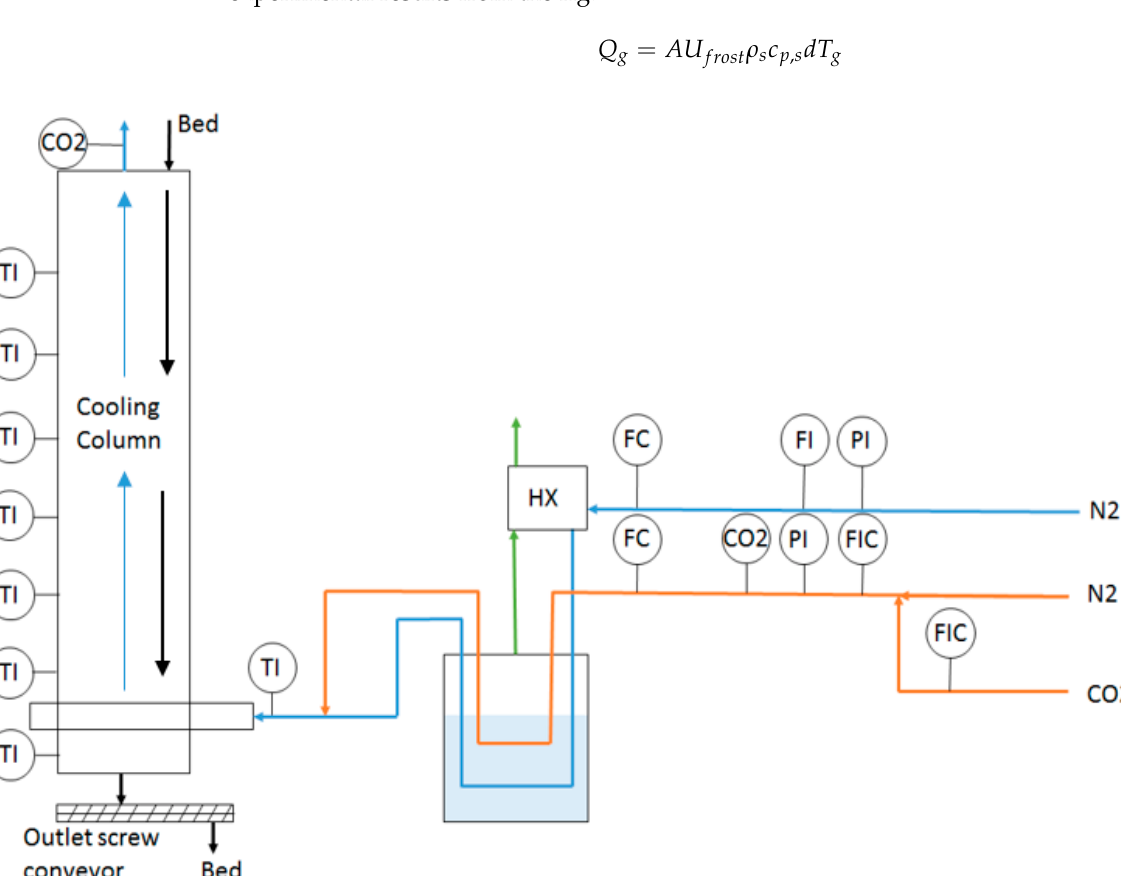
Table 1. Inlet flue gas flow rate conditions for cryogenic rig simulation.